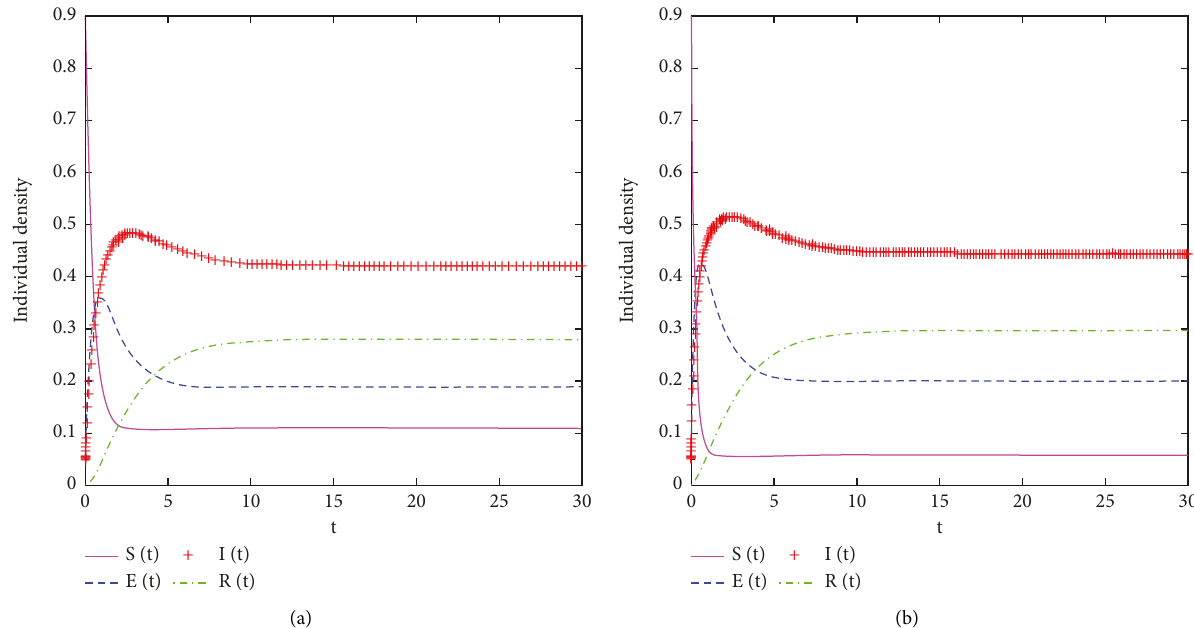
Figure 6: Simulation results of infected enterprises’ switching out rate on credit risk contagion. (a) ρ � 0.2. (b) ρ � 0.4.